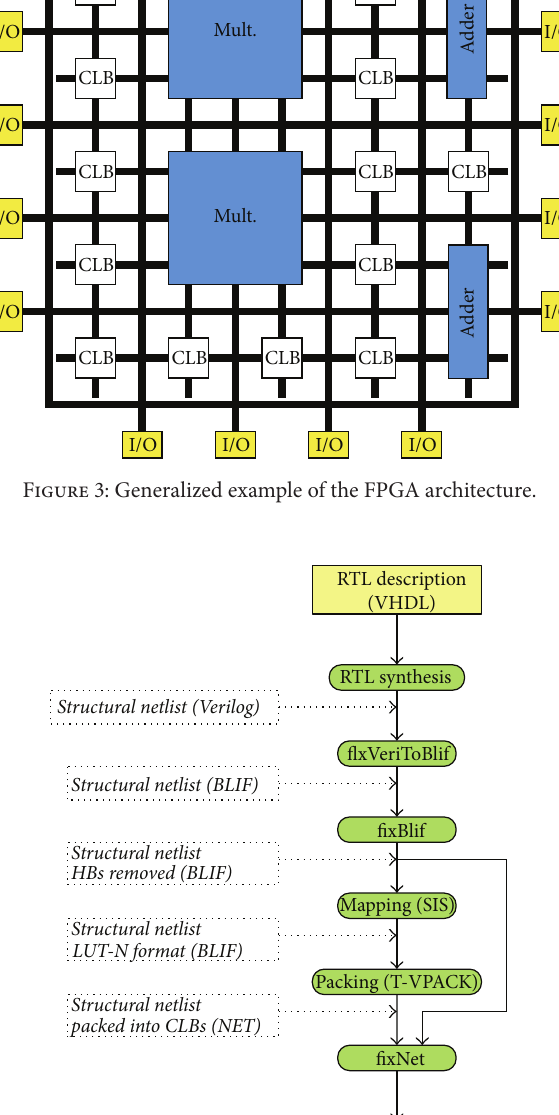
Structural netlist CLBs and HBs